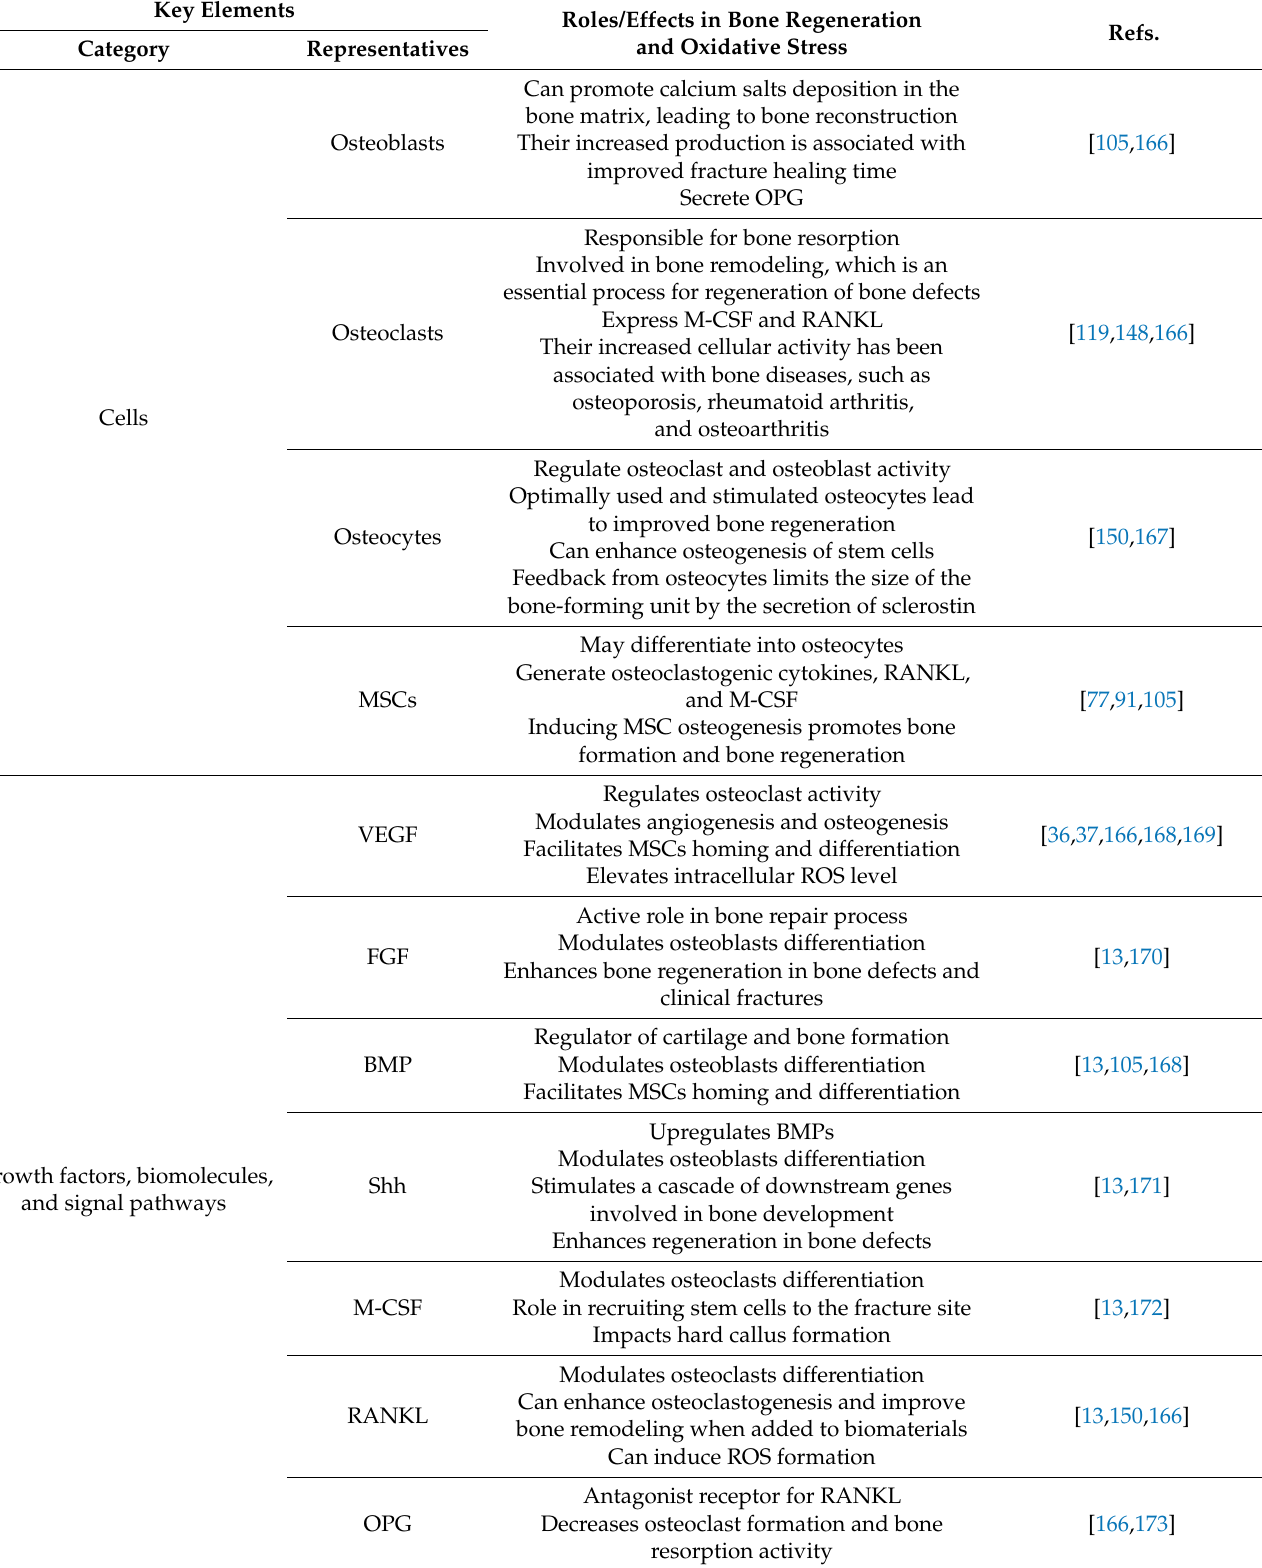
Table 3. Overview of relevant elements for bone regeneration and oxidative stress. Key